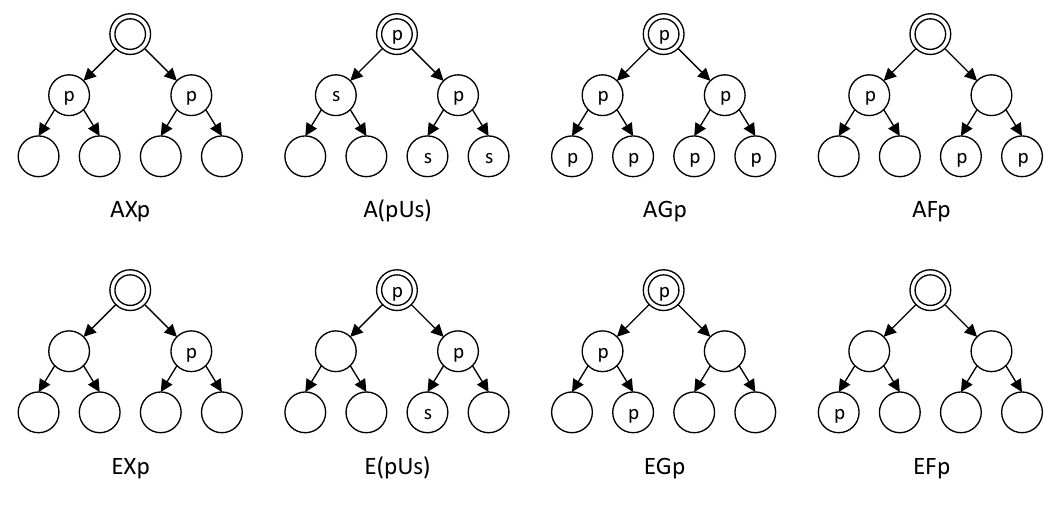
Figure A2. Time operators in